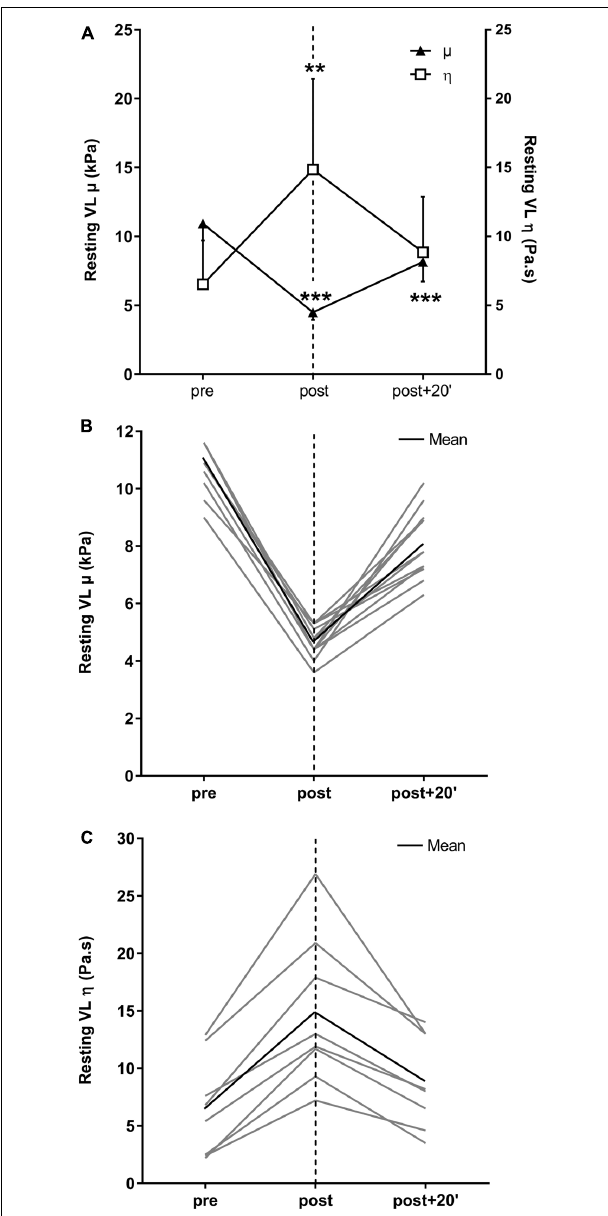
FIGURE 5 | Shear elasticity ( µ ) and viscosity ( η ) of the vastus lateralis (VL) muscle extracted from the group velocity and Voigt’s model using the dispersion measurement (A) . Individual values for µ (B) and η (C) . Mean ± SD. ** P < 0.01 and *** P < 0.001, significant differences from pre-exercise (pre)